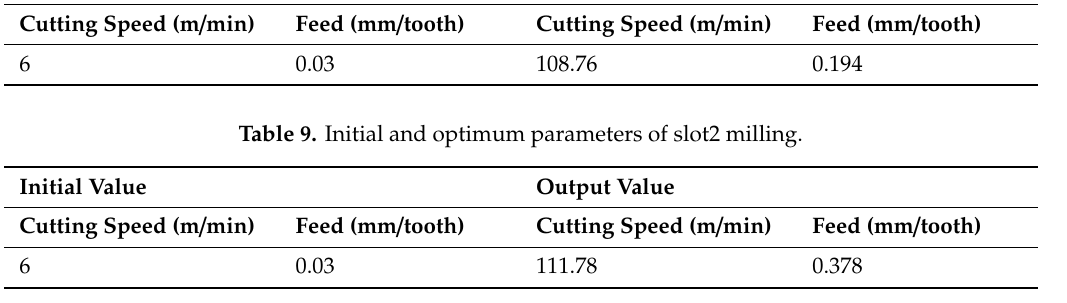
Table 10. Results by using optimum parameters.